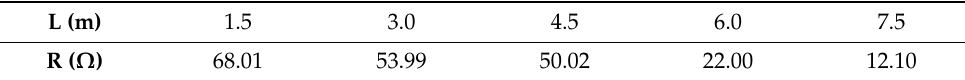
Table 6. Buried rod length L (m) and the corresponding measured grounding resistance R ( Ω ) of the rod located in Girona.